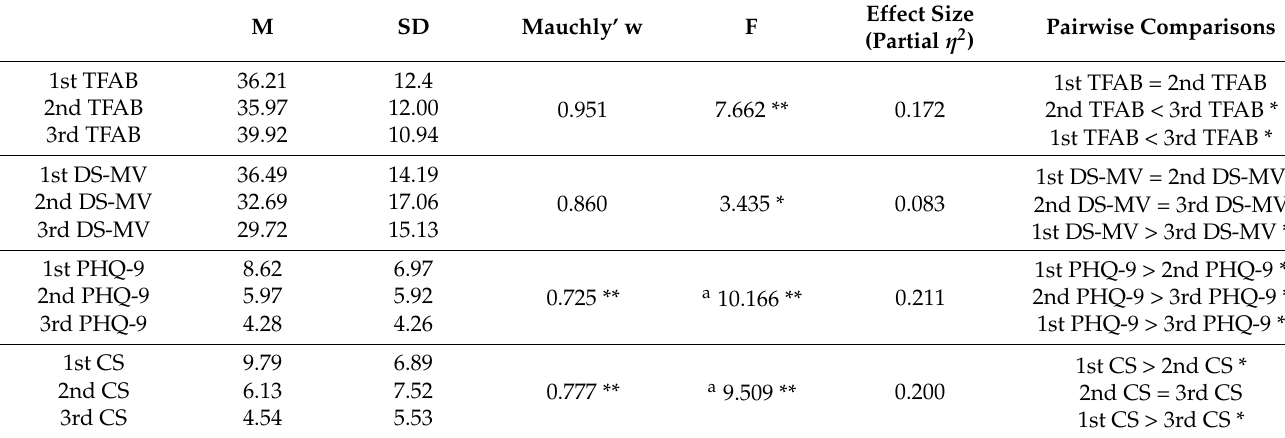
Table 3. Fully attended group repeated-measures ANOVA (n =